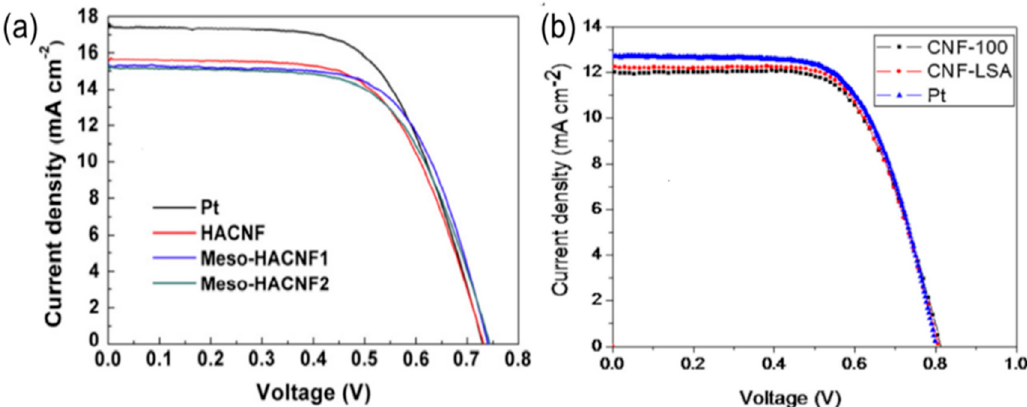
Figure 14. ( a ) Photocurrent–voltage curves for HACNFs, meso-HACNF1, meso-HACNF2, and Pt-based CEs. Reprinted with permission from Reference [57]. ( b ) Photocurrent–voltage curves for a quasi-solid-state electrolyte DSC with CNFs or Pt deposited on an Indium tin oxide coated polyethylene terephthalate (ITO / PET) flexible substrate as CE. Reprinted with permission from Reference [89].